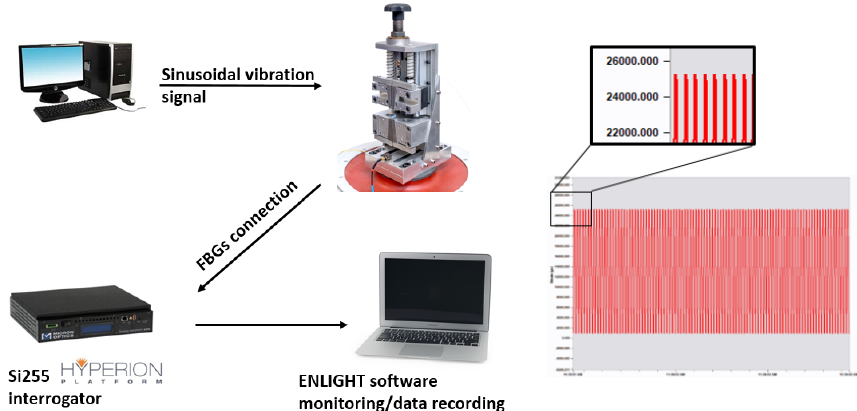
Figure 4. Complete fatigue testing experimental setup including an example time history of the strain